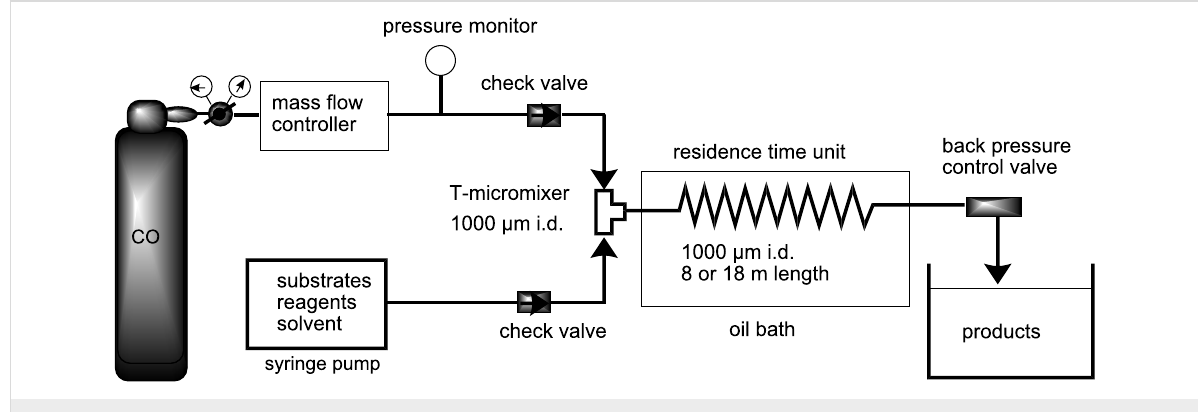
Figure 1: Microflow system available for radical carbonylation using pressurized CO.